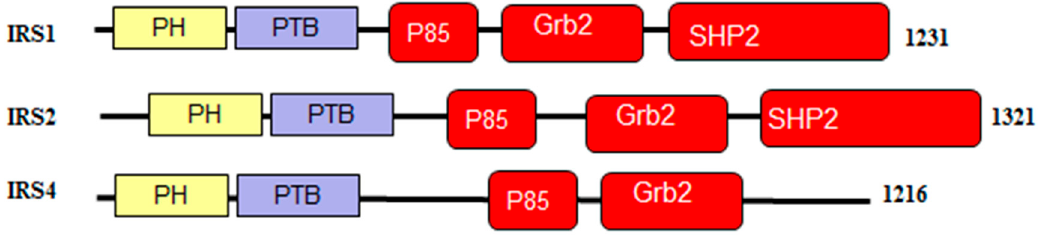
Figure 5. Schematic representation of the signaling domains in the proteins from human IRS family. Here, PH, is Pleckstrin homology domain; PTB, is the phosphotyrosine-binding domain; Src homology region 2-containing protein tyrosine phosphatase 2 (SHP2) binding domain is present in IRS1 and IRS2, and is not found in IRS4.